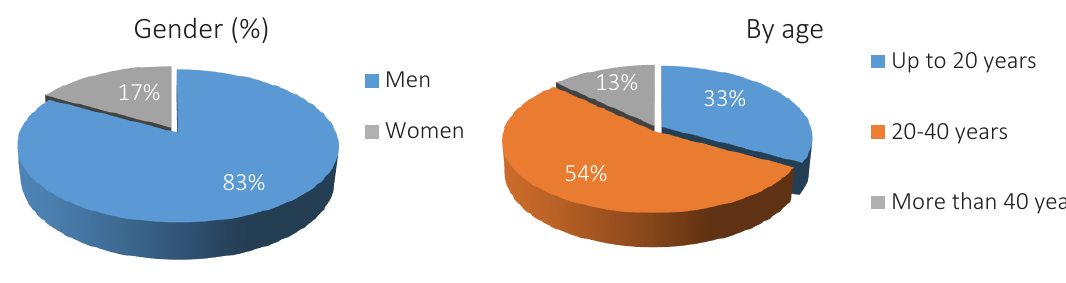
Source: Materials of criminal